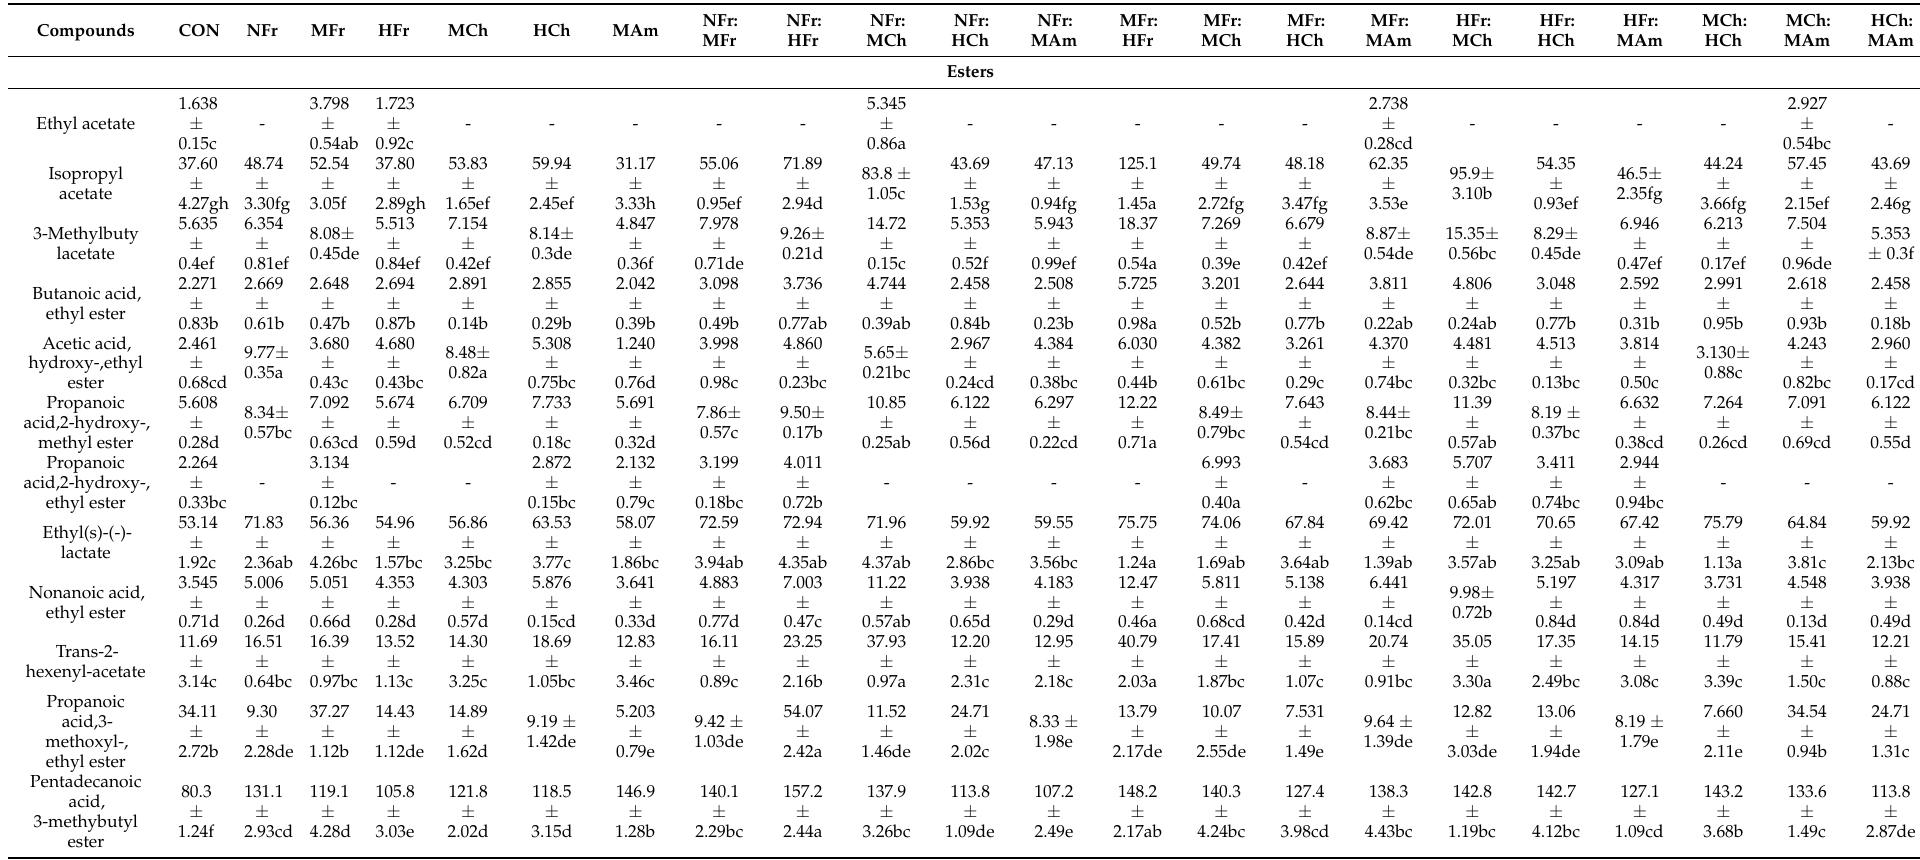
Table 5. Quantitative analysis of the aroma compounds of wines aged with oak chips. All values are expressed as means ( µ g/mL) ± standard deviation